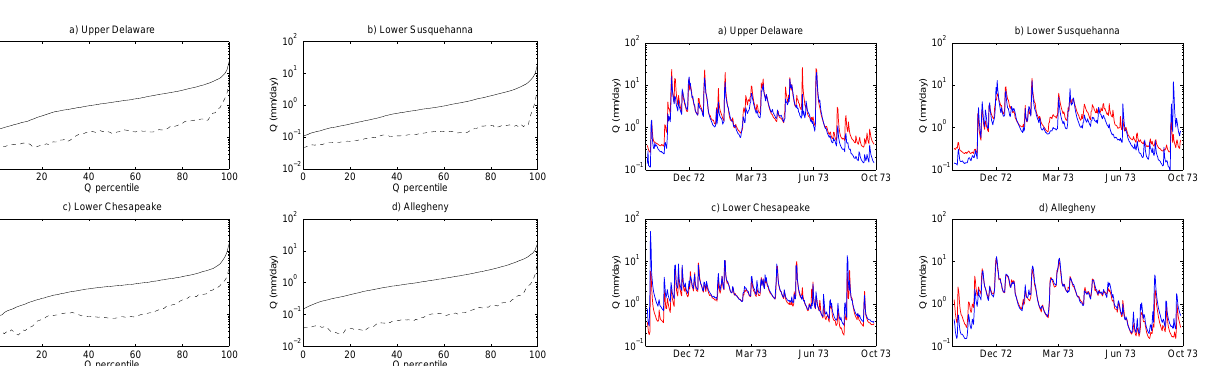
Fig. 6. Spatial mean (solid line) and standard deviation (dashed line) of catchment streamflow percentiles within (a) Upper Delaware, (b) Lower Susquehanna, (c) Lower Chesapeake, and (d) Allegheny basin.